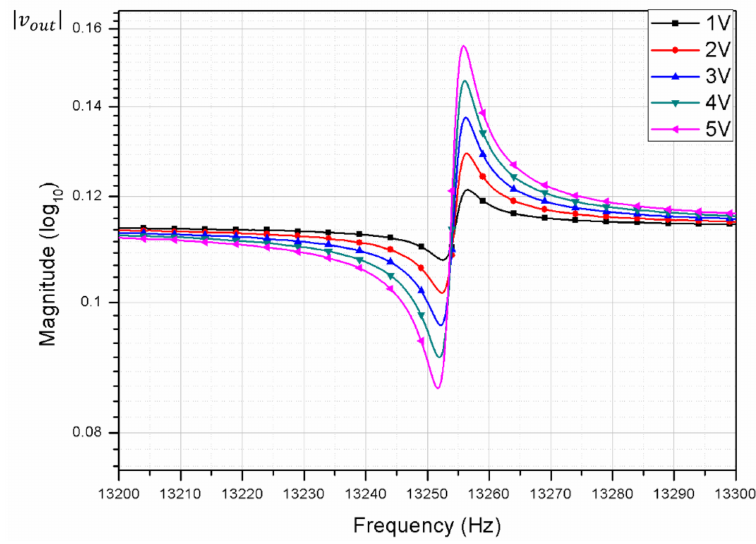
Figure 7. Frequency response of a resonator from increasing the DC voltage at a fixed AC voltage of 1 V pk .